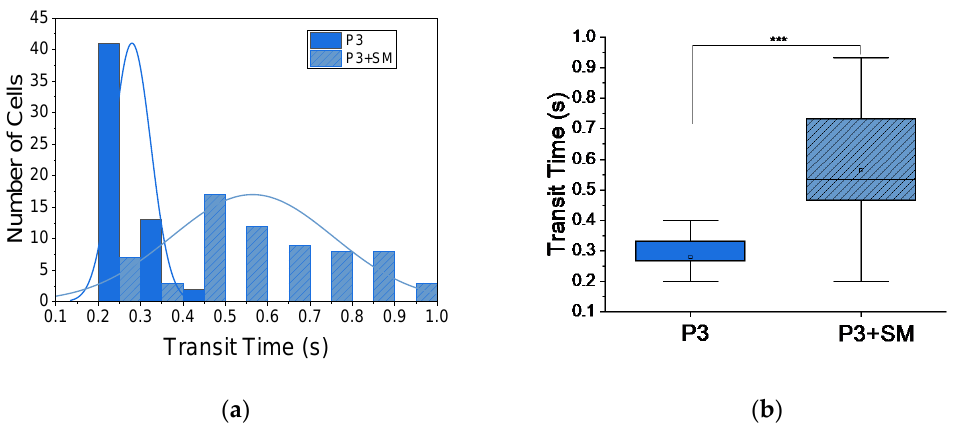
Figure 5. Decrease in transit times following induced hypoxia. ( a ) Histogram distribution of transit times for patient 1, P1, normal (Gaussian) fit, with decrease in transit time when treated with SM. ( b ) Box plot of two-sample t-test, showing significant (*** p < 0.001) decrease in mean transit time tt from 0.38 ± 0.01 s to 0.32 ± 0.01 s for patient 1 (P1, n = 56 cells) and patient 1 treated with sodium metabisulfite (P1 + SM, n = 63).